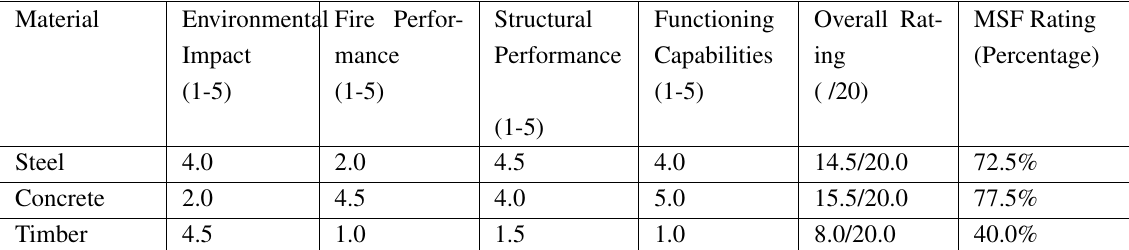
Table 4. Materialselection factors (MSF)